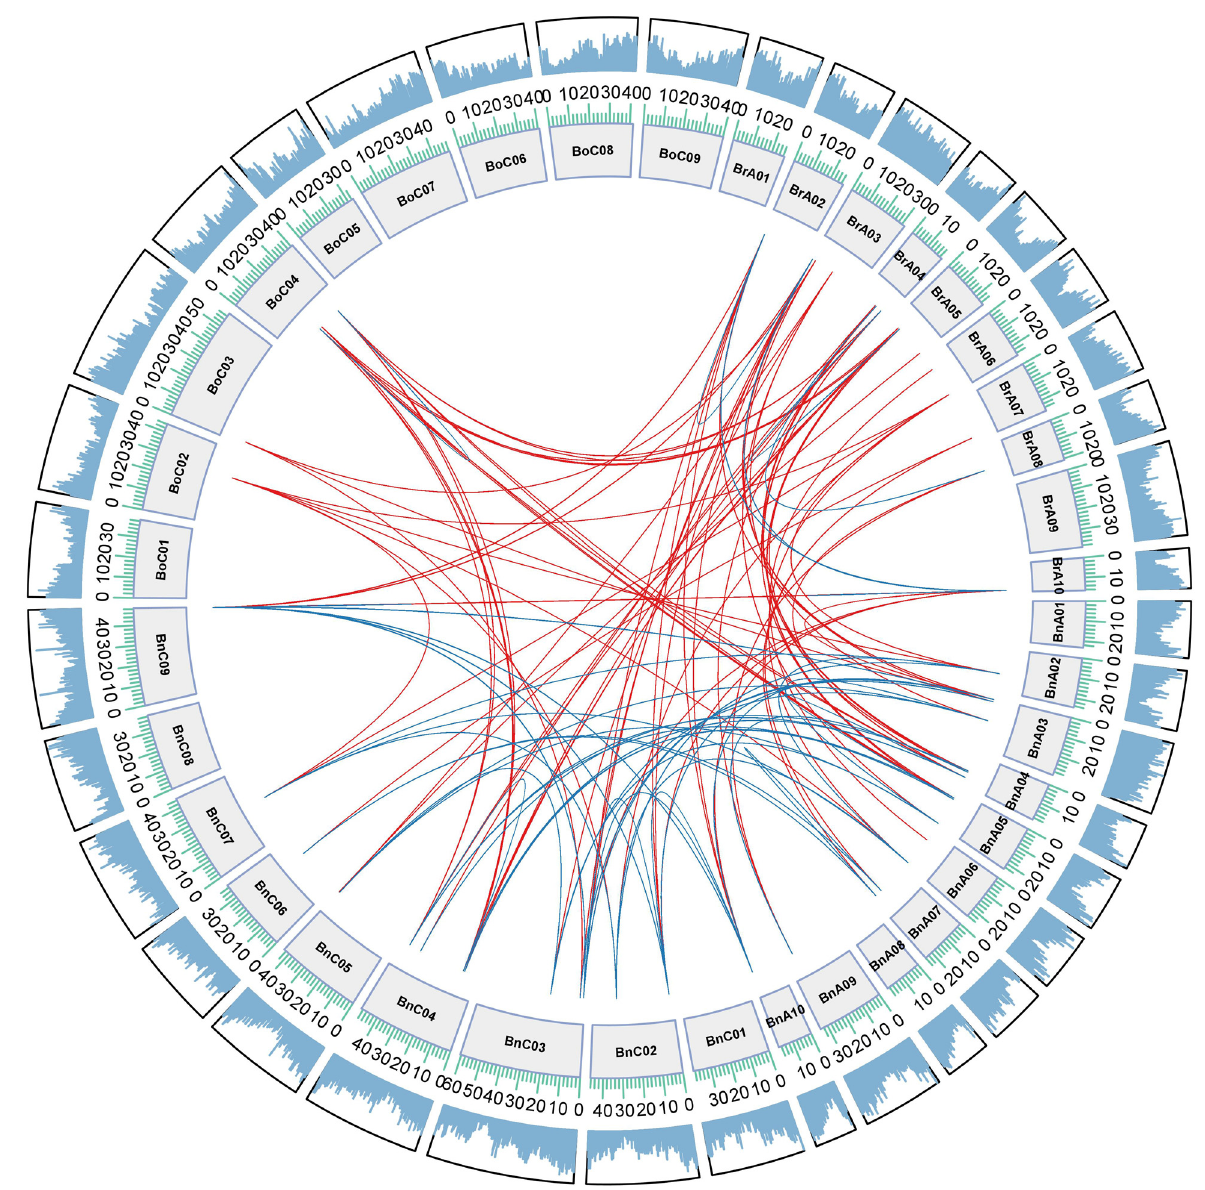
Figure 5. Genome-wide synteny analysis of A n and C n subgenome in B. napus , and A r genome in B. rapa , and C o genome in B. oleracea . Blue lines in the figure represented the paralogous genes and red represented orthologous genes. The outer ring was gene density on chromosome. The inner circle was the chromosome name and its length scale.